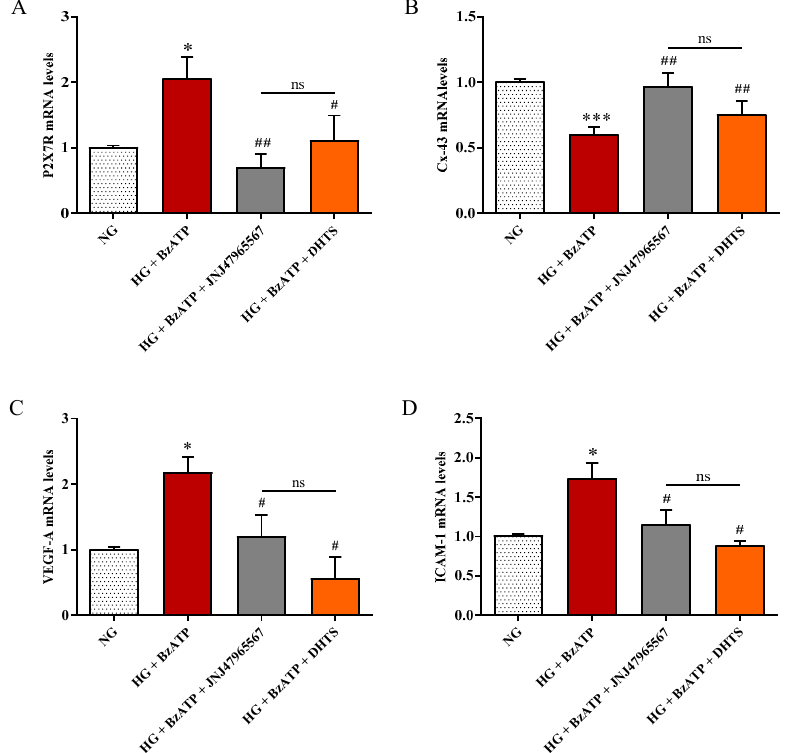
Figure 8. Measurement of ( A ) P2X7R, ( B ) Cx-43, ( C ) VEGF-A, and ( D ) ICAM-1 mRNA expression levels (qRT-PCR) in endothelial cells under our experimental conditions. NG = normal glucose condition (5 mM). HG = high glucose condition (40 mM). BzATP = 200 µ M. JNJ47965567 = 100 nM. DHTS = 500 nM. The abundance of each mRNA of interest was expressed relatively to the abundance of 18S rRNA, as an internal control. Values are means ± SD of three independent experiments. * p < 0.05 vs. NG. *** p < 0.001 vs. NG. ## p < 0.01 vs. HG + BzATP. # p < 0.05 vs. HG + BzATP. ns = not